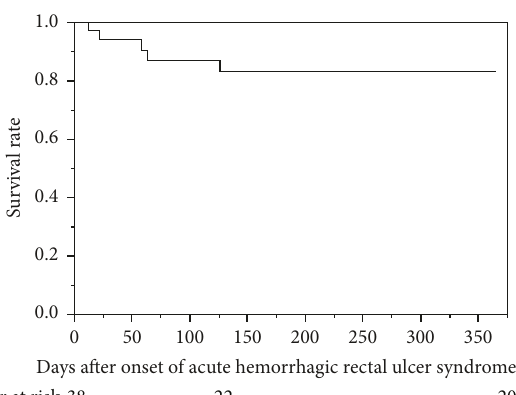
Figure 3: Kaplan-Meier estimates after onset of acute rectal hemorrhagic rectal ulcer. 17 percent of patients with acute hemorrhagic rectal ulcer syndrome (AHRUS) died of non-AHRUS problem in one